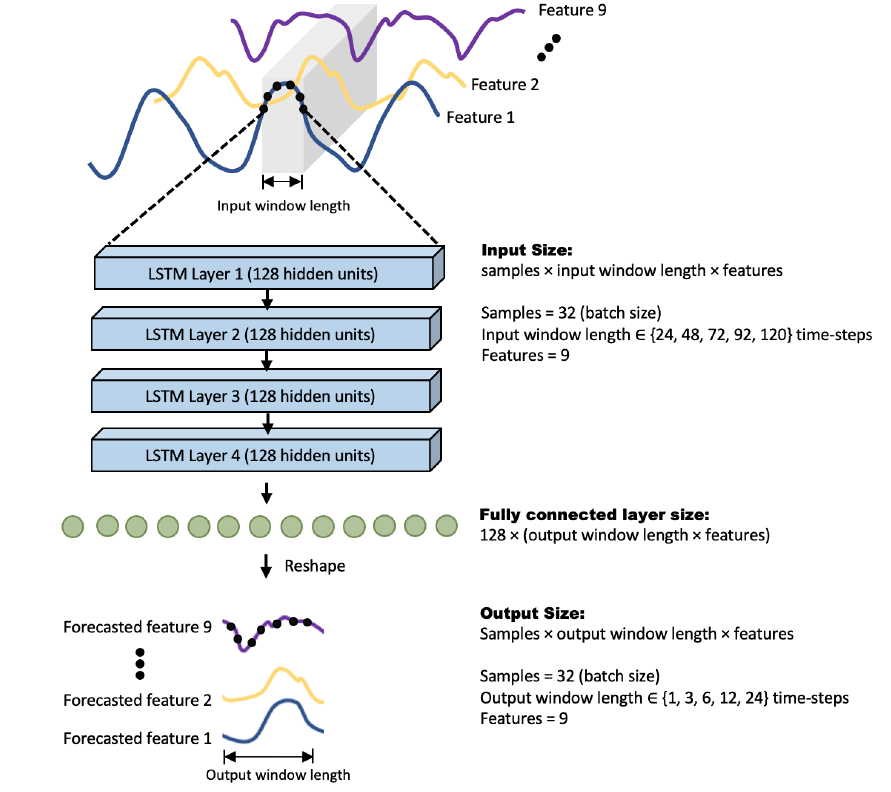
Figure 2. Architecture of the LSTM network used in this